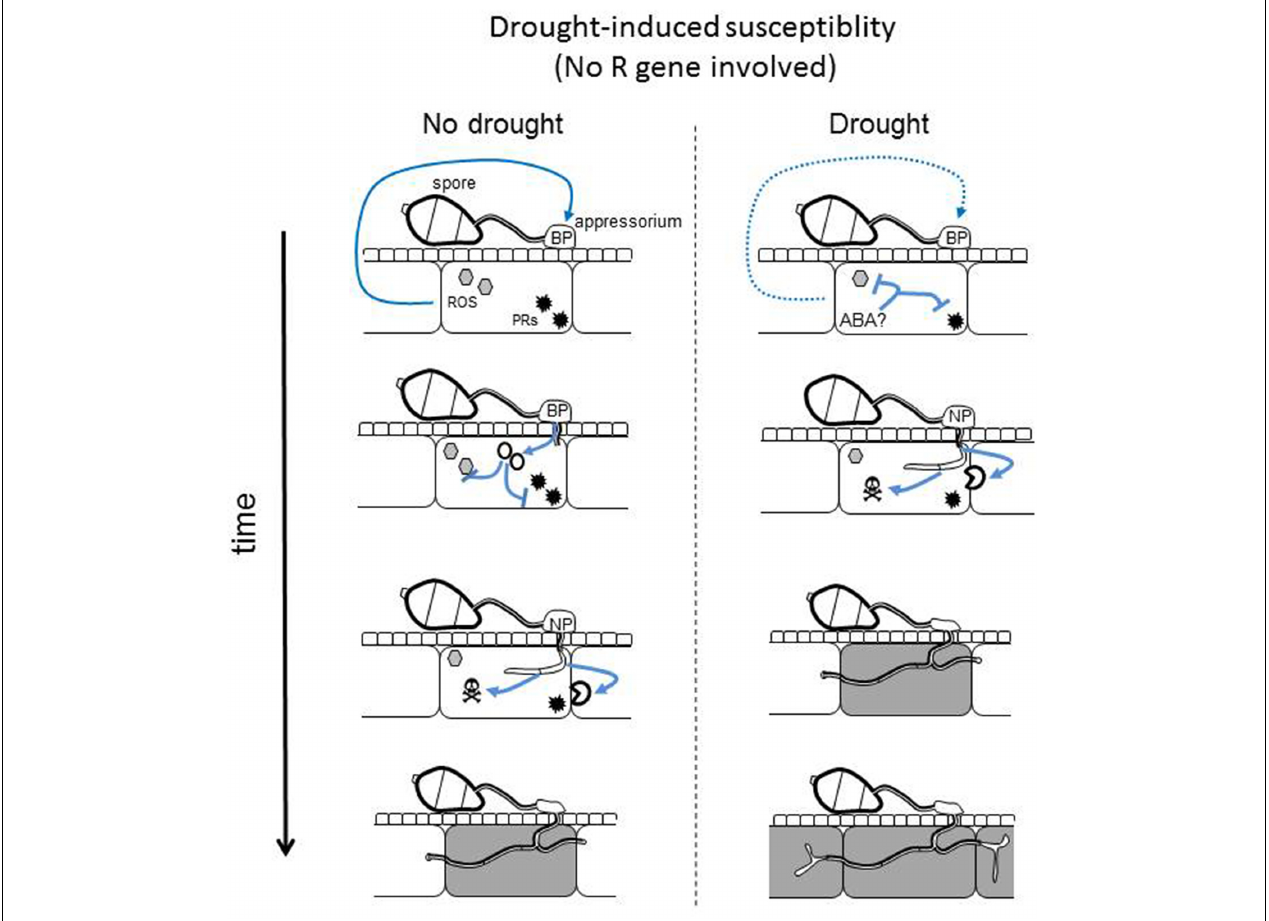
FIGURE 5 | Hypothetical model for drought-induced susceptibility. Under non-stressed conditions, an unknown plant signal informs the fungus on the level of plant’s immunity (blue arrow). This signal activates the fungal pathogenicity program associated with biotrophy (BP): effectors are produced (red circles) to inhibit plant immune response including ROS (gray hexagons) and defense proteins (black stars). Once immunity inhibited and biotrophy established, a nectrotrophy program (NP) is activated that produces cell wall degrading enzyme and other toxin activities, leading to plant cell death (gray cell) and pathogen facilitated growth. After the response to drought, some plant signals like ABA and the production of antioxidant activities might inhibit the production of the immune response. The unknown plant signal indicative of high immunity is weaker or no longer present (dashed arrow). In the absence of this signal, the fungus is rapidly activating its necrotrophic